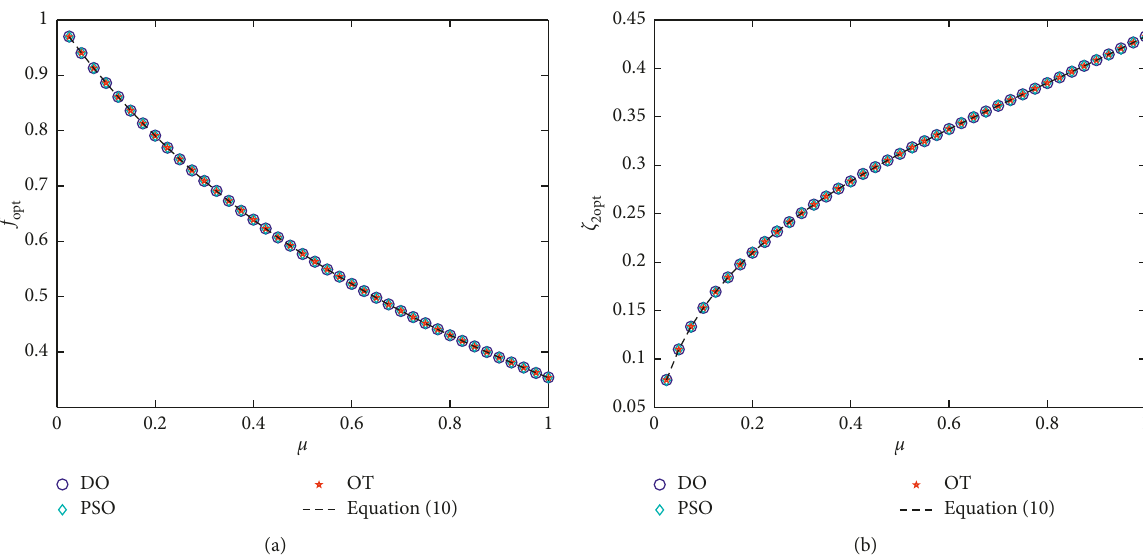
Figure 2: Comparison of numerical optimisation algorithms and theoretical results. (a) Optimisation results of the frequency ratio. (b) Optimisation results of the damping